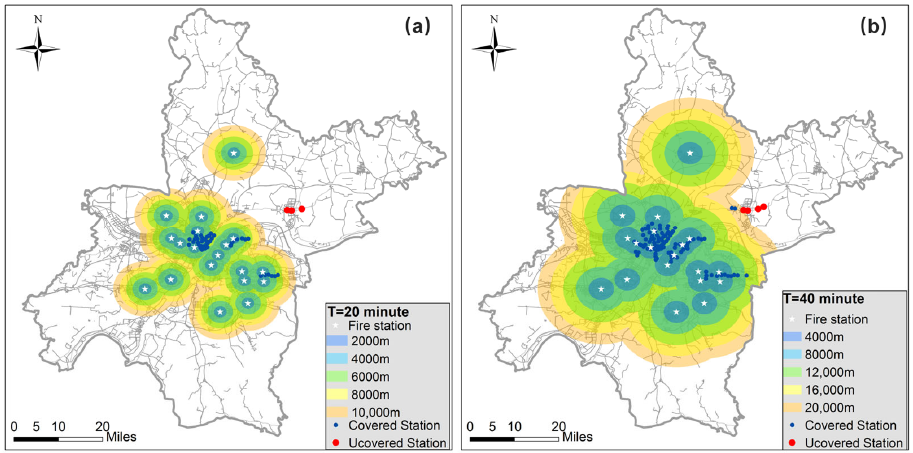
Figure 19. Emergency response zone at T = 20 min ( a ) and T = 40 min ( b ).